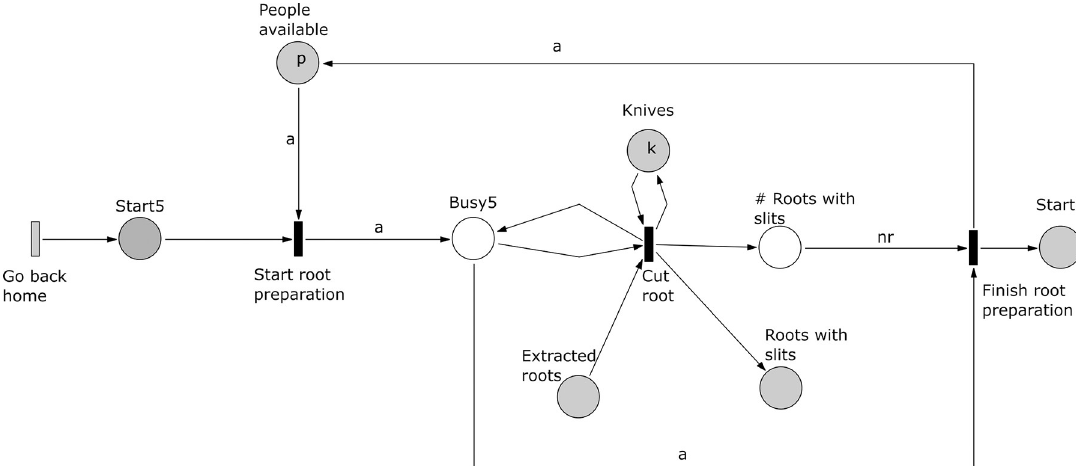
Fig 16. Subprocess 5 Root Preparation of the O . Schinzii